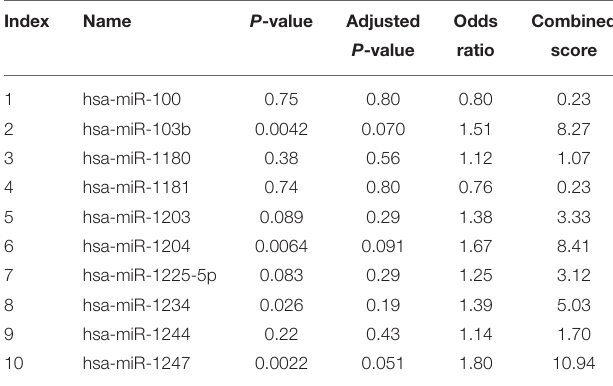
TABLE 6 | Identification of target miRNA of DEGs